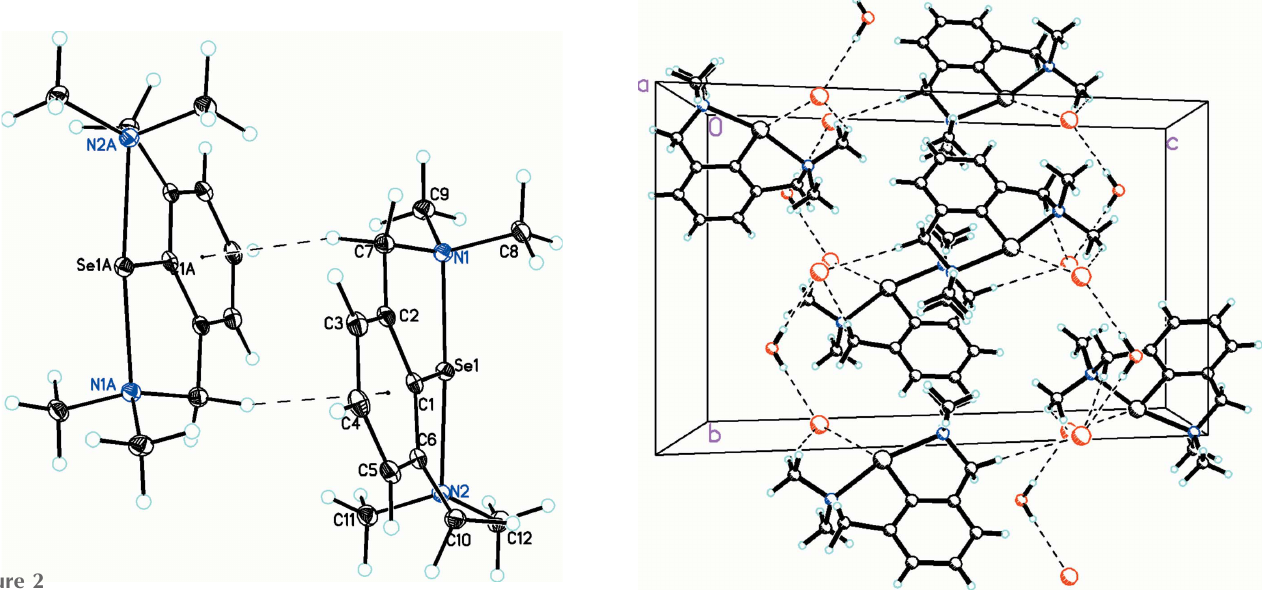
Figure 3 Packing diagram viewed along [100] showing O—H (cid:2)(cid:2)(cid:2) Br and C—H (cid:2)(cid:2)(cid:2) Br interactions generating a staggered chain in the [010]